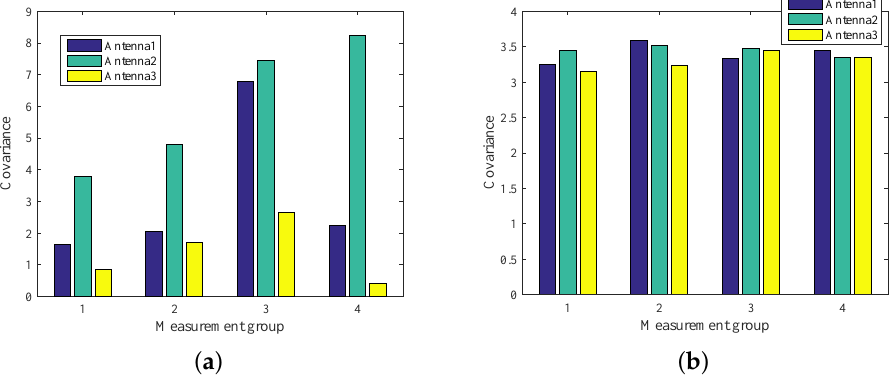
Figure 6. Antenna diversity: ( a ) antenna diversity of amplitude features; ( b ) antenna diversity of phase